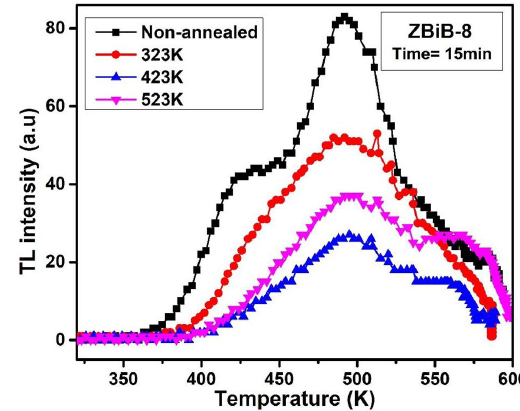
Figure 14. TL glow curve of thermally annealed ZBiB-8 glass at different temperatures for 15 min.